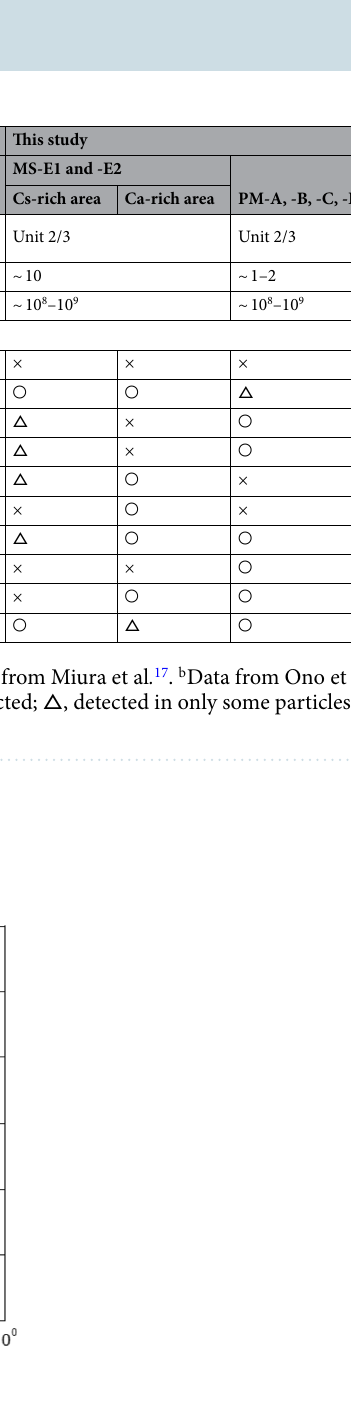
Figure 4. Relationships between 137 Cs activity and particle volume ( 137 Cs activity per unit volume) of Type-A and Type-B particles, reported by Miura et al . 17 , compared with that of the marine RPs in this study. 137 Cs activity per volume of RPs from marine samples is similar to that of terrestrial Type-A particles. The relationship in sample SP reported by Zhang et al . 24 is also